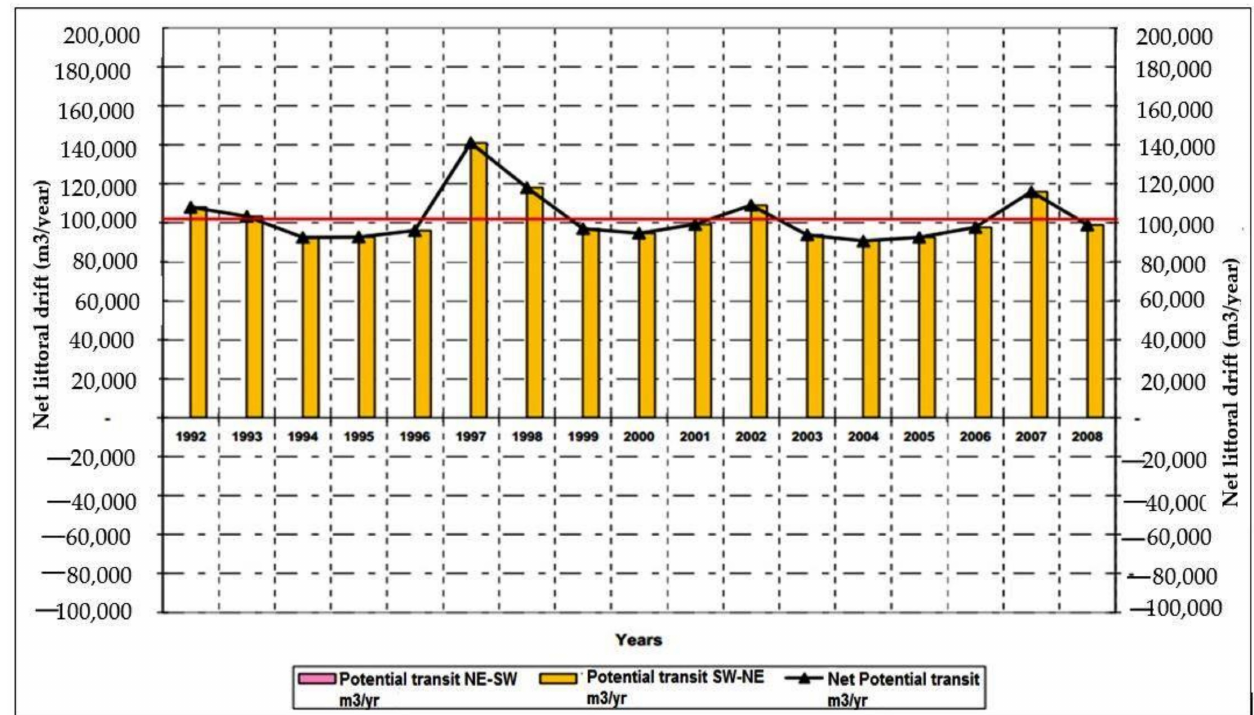
Figure 11. Sediment transport by littoral drift on the Kribi coast (Source: Kribi sea port